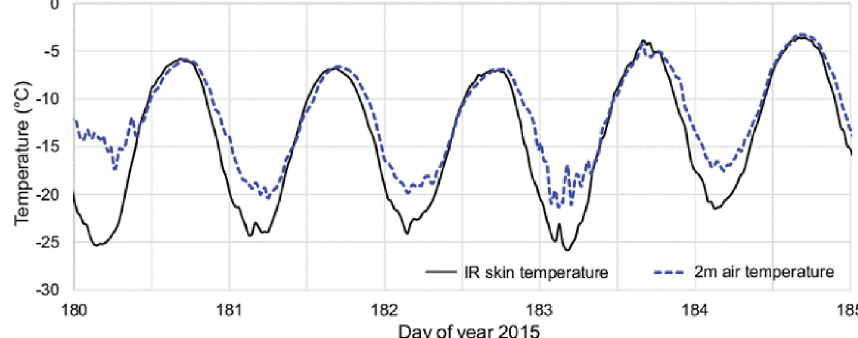
Fig. 7. Time series of temperatures: during a clear sky period near Summit, Greenland. IR skin 2 m in air (acc. Adolph et al.